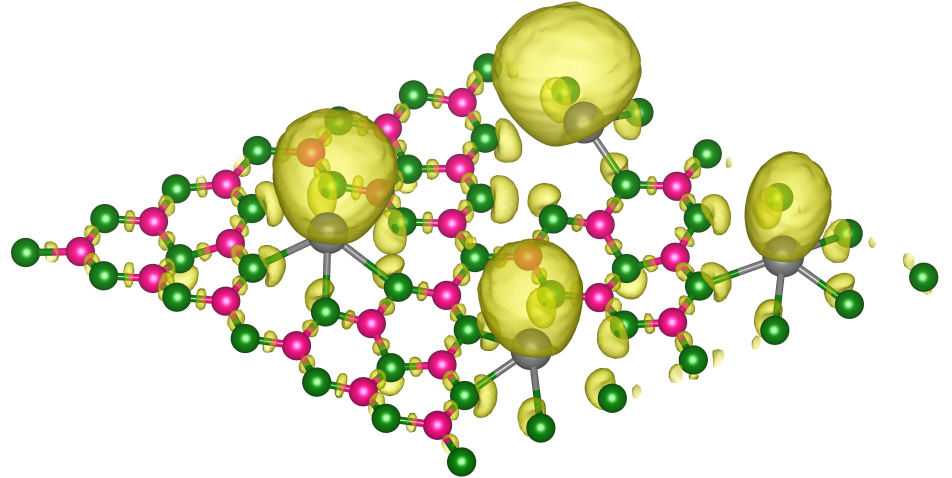
Figure 3. The PDOS of the Al-decorated g-C with respect to the Fermi energy.